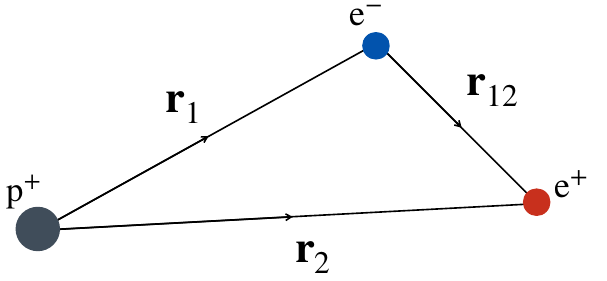
Figure 1. A diagram of the positron–hydrogen system with the interparticle distances